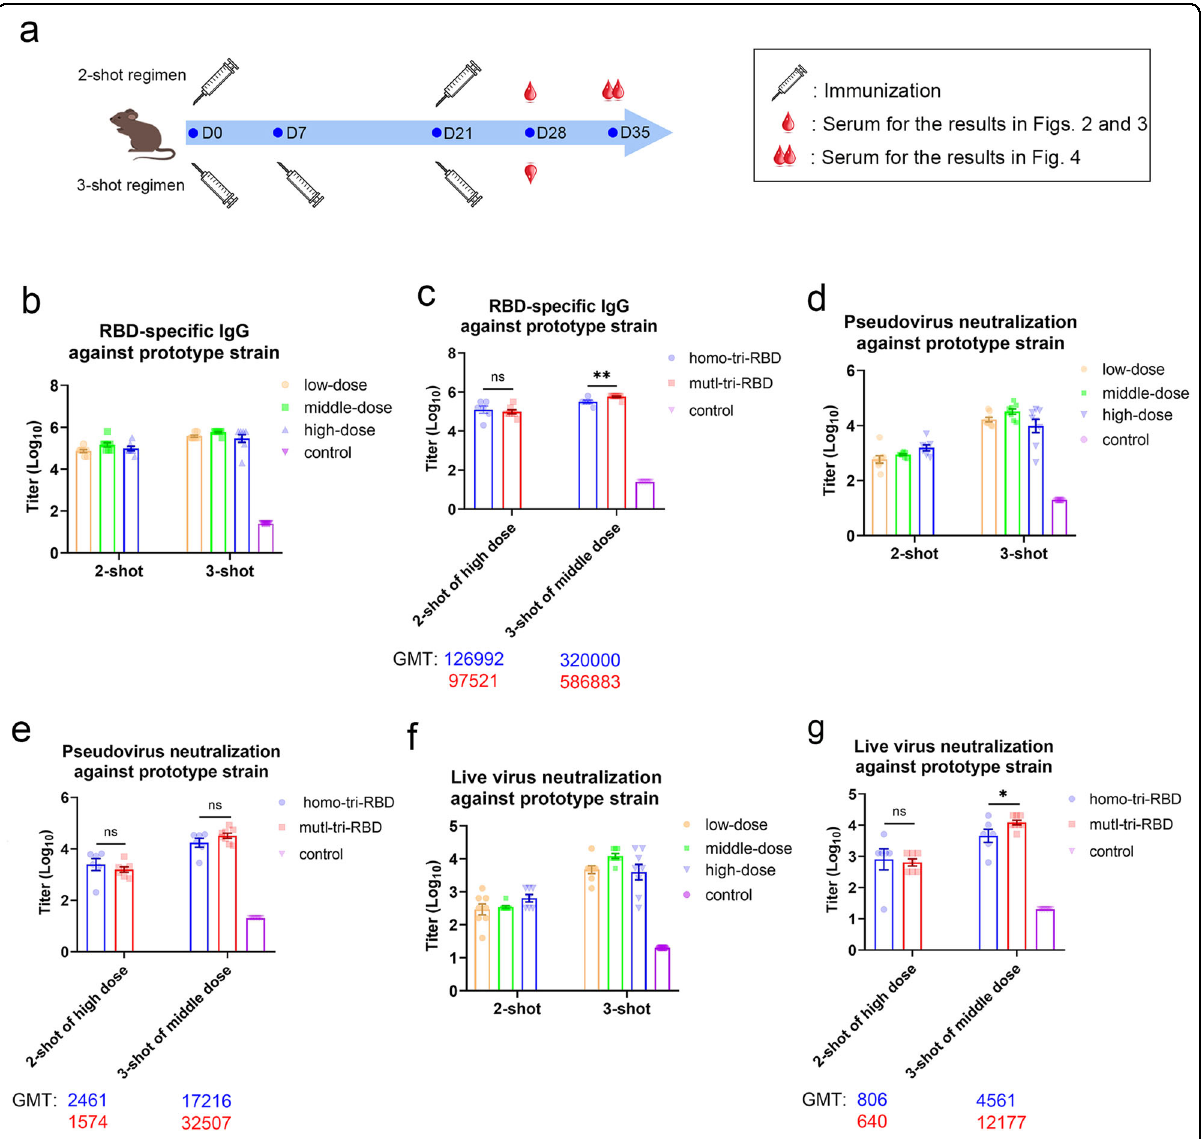
Fig. 2 mutI-tri-RBD and homo-tri-RBD elicited similarly high levels of the immune response against the SARS-CoV-2 prototype strain in mice. The mice were immunized with two-shot or three-shot injections, and for each shot, three different doses were used, including low (0.125 µg/ dose), middle (0.5 µg/dose), and high (2.0 µg/dose) doses, respectively. a The timeline of vaccine immunization and serum collection. The levels of speci fi c IgG elicited by mutI-tri-RBD in the sera collected on day 7 post-immunization (D28 in a ), were detected with ELISA by using monomeric RBD of prototype SARS-CoV-2 strain, and the titers of neutralizing antibodies against the prototype strain were assessed by using the pseudo- and live virus neutralization assays. b , d , f An obvious dose-dependent response of the RBD-speci fi c IgG ( b ) as well as pseudo-virus ( d ) and live-virus ( f ) neutralizing antibodies induced by mutI-tri-RBD were observed. c , e , g The RBD-speci fi c IgG level ( c ), and the neutralizing antibody titers against the pseudo ( e ) and live ( g ) viruses elicited by mutI-tri-RBD were similar to those elicited by homo-tri-RBD. Data are presented as means ± SEM. P values were calculated by using one-way ANOVA followed by Sidak ’ s multiple comparison test. * P < 0.05, ** P < 0.01, ns, not signi fi